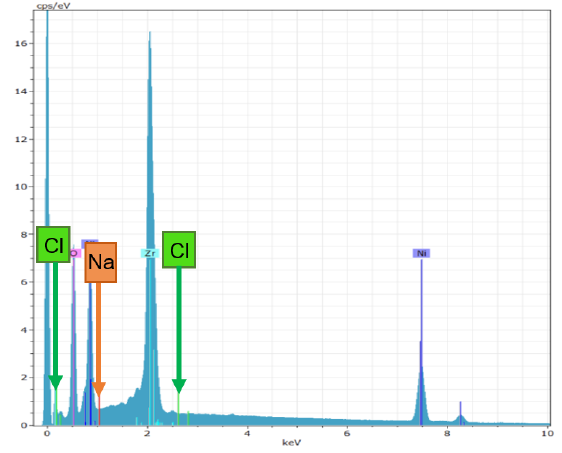
Figure 5. EDX results of elemental mapping on the cell surface.